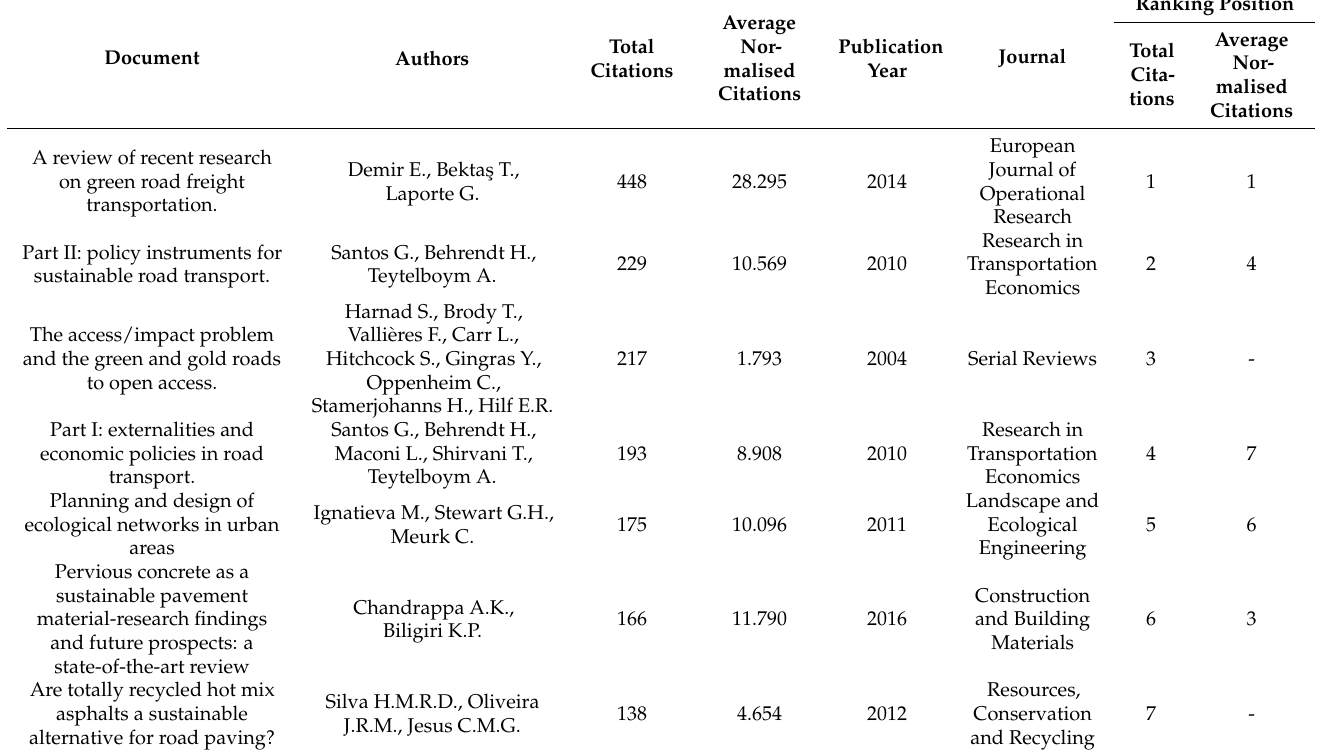
Table 5. Main documents in terms of total citations and average normalised